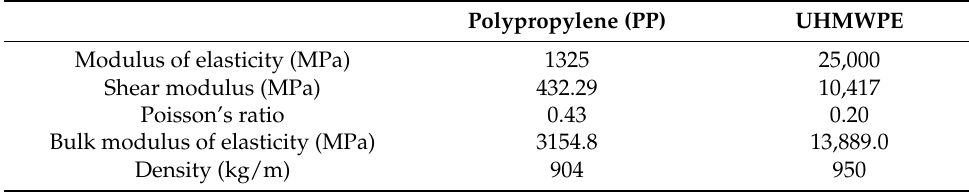
Table 1. Properties of PP and